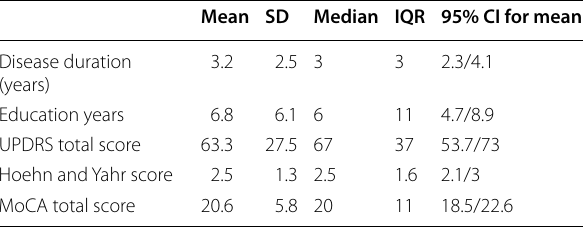
UPDRS Unified Parkinson’s Disease Rating Scale; MoCA Montreal Cognitive Assessment; SD standard deviation; IQR interquartile ratio, CI confidence interval